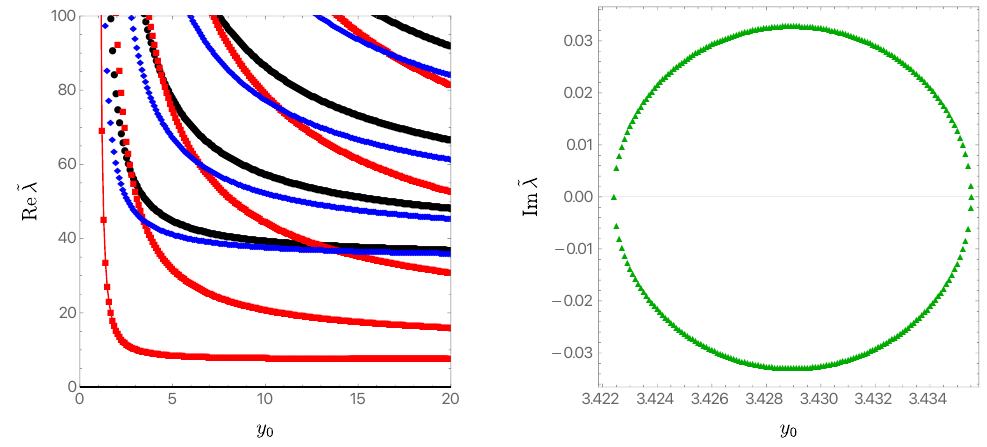
Figure 6 . The real part (left panel) of the excited modes as a function of y 0 ∈ (1 . 1 , 20) and y + = 20 . In the right panel we plot the imaginary part of e λ in a magnified description of the region where the first excited non-gauge mode with negative norm crosses the first excited non-gauge mode with positive norm. The colour coding is as follows: green triangles are non-gauge modes with complex eigenvalues; blue diamonds are non-gauge modes with negative norm under ˆ G ; red squares are non- gauge modes with positive norm under ˆ G and the black disks are pure gauge